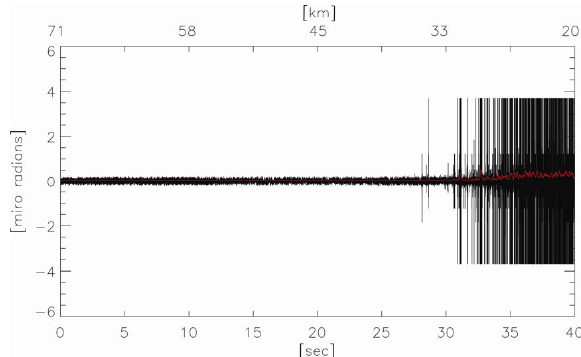
Figure 5 Angular fluctuation of the fine pointing mechanism along the x-direction recorded at OPALE, 07:22:00 UTC was set to 0 in this plot. The red line is the average calculated at 0.1 second intervals of the corrections.